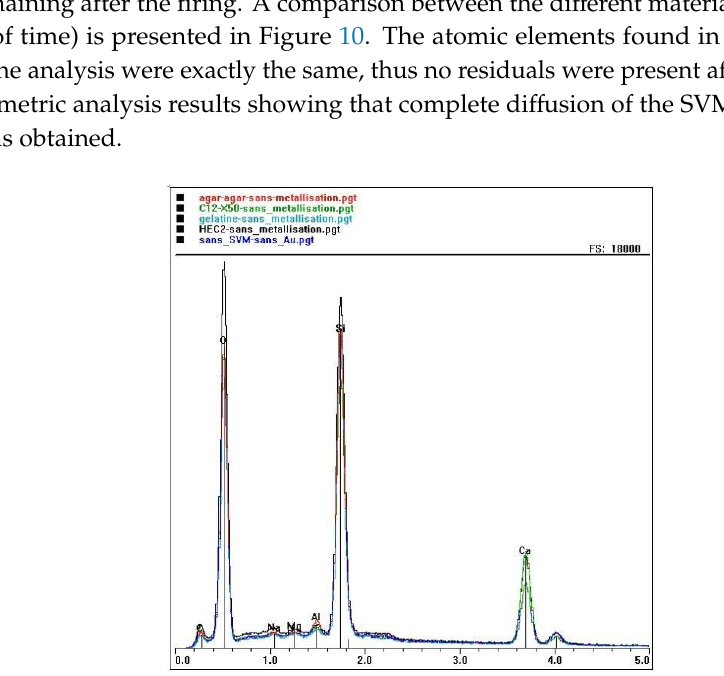
Figure 10. Energy-dispersive X-ray spectroscopy (EDX) spectrum for the different materials (except HEC 5 wt%). The plot colors indicate the materials as follows; HEC 2 wt% (black), agar-agar (red), gelatin (light blue), carbon paste (green) and no SVM (blue).